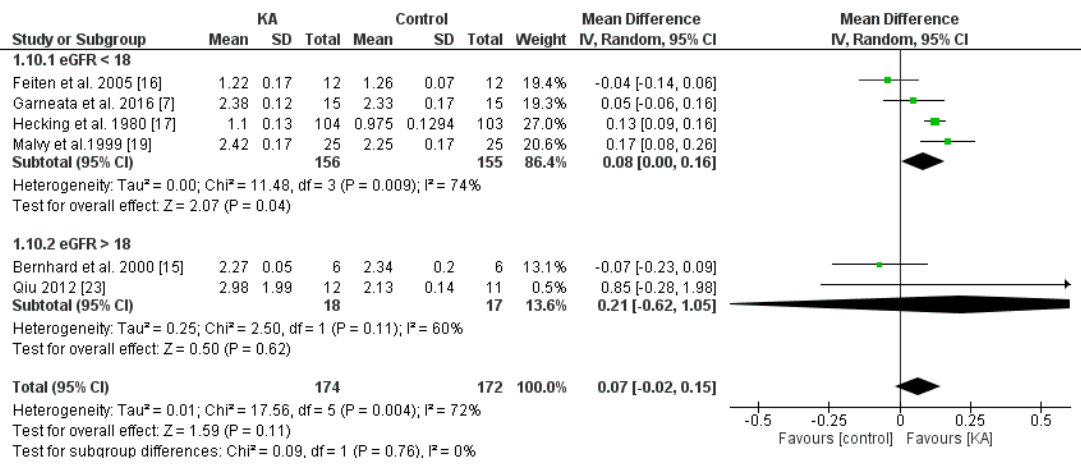
Figure 12. Forest plot of effects of KA on parathyroid hormone (PTH) in CKD patients sub-grouped by eGFR. The random-effects model was utilized. 3.5. Risk of Bias and Quality Assessment The assessment of risk of bias is shown in Figure 13. The majority of the studies (more than 75%) showed low risk of reporting and attrition; however, low risk and/or unknown risk in selection, detection, performance, and other bias cannot be excluded.